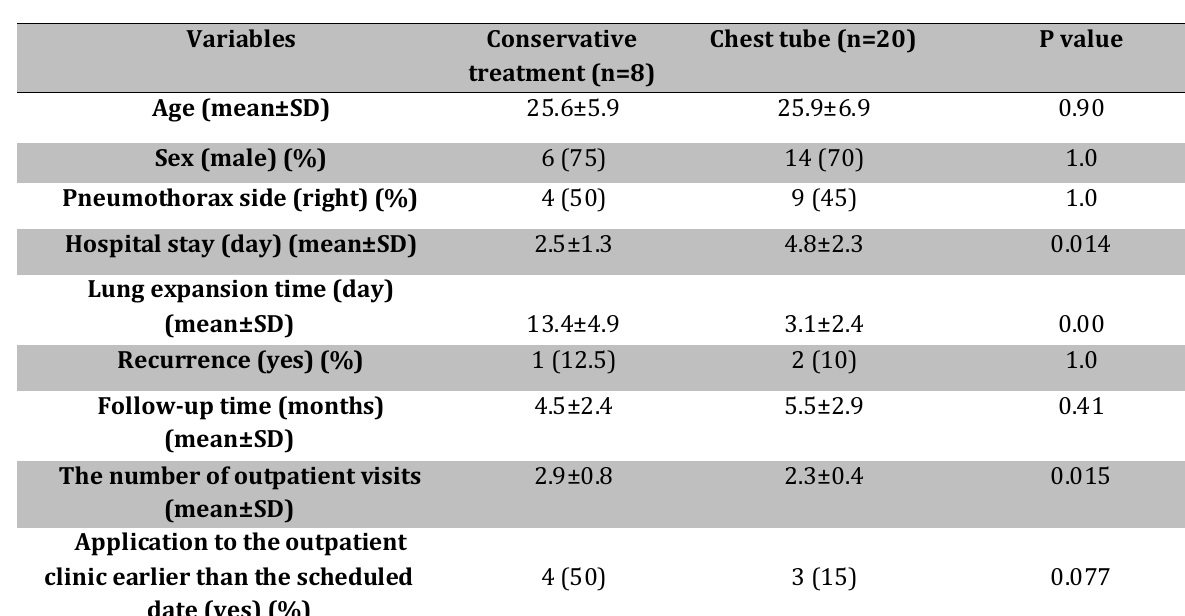
Table 1. Characteristics of